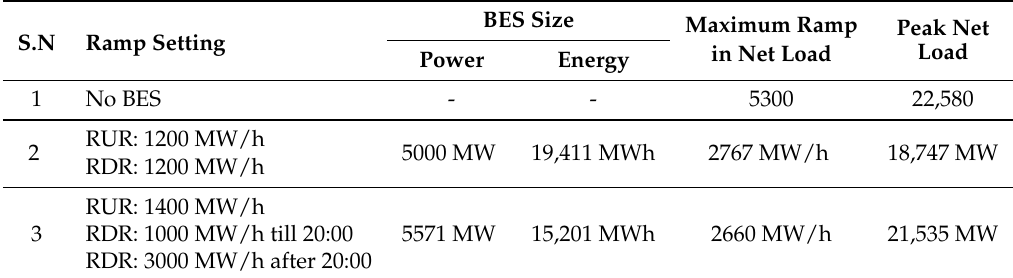
Table 5. Impact of ramp rate settings on daily power